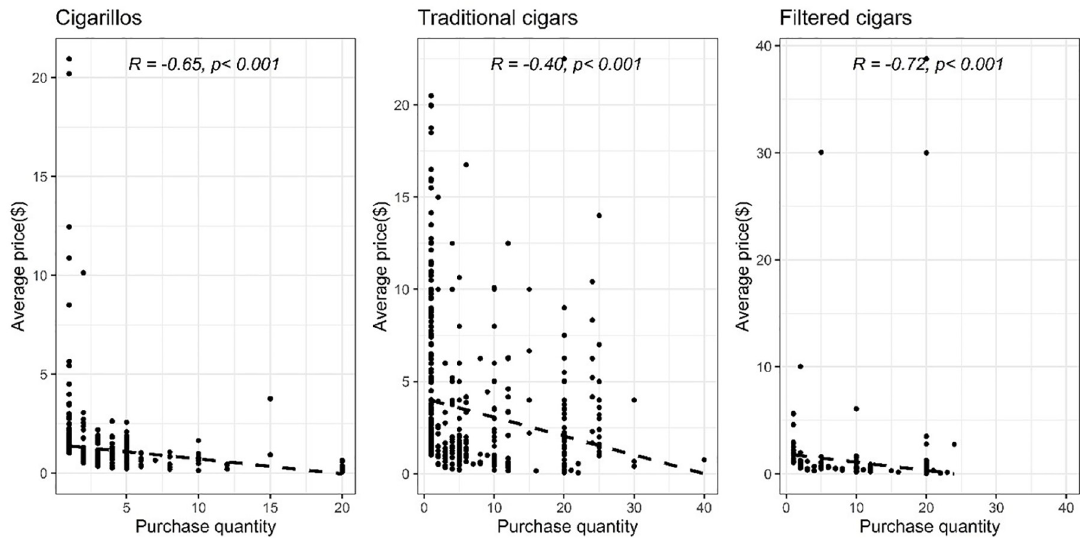
Fig 1. Spearman’s correlation between average price per cigar and purchase quantity.